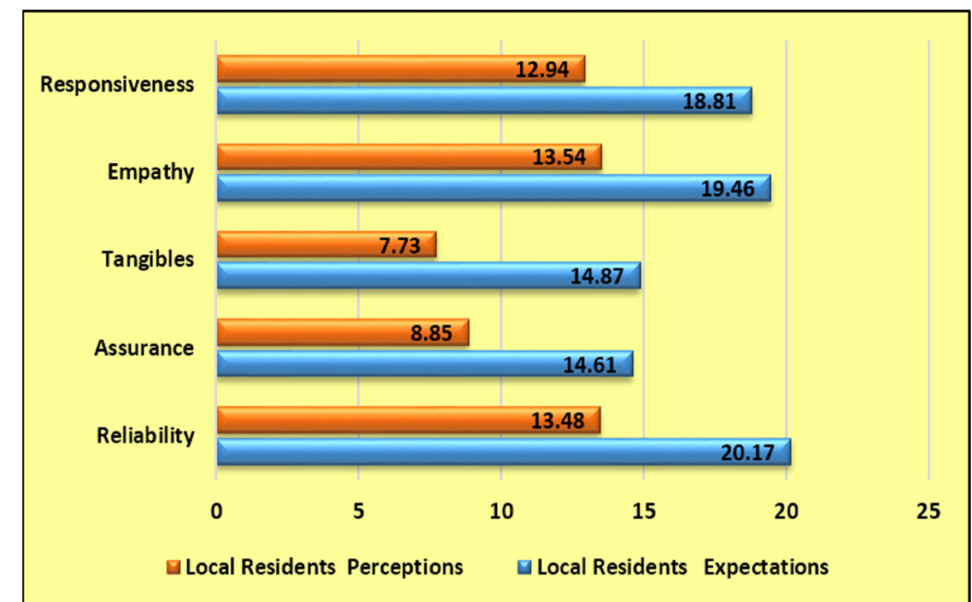
Figure 5. Expectations and perceptions of residents about IoT as a sustainable energy management solution at tourism destinations (pictures 1–5 showing means scores for Reliability, Assurance, Tangibles, Empathy, and